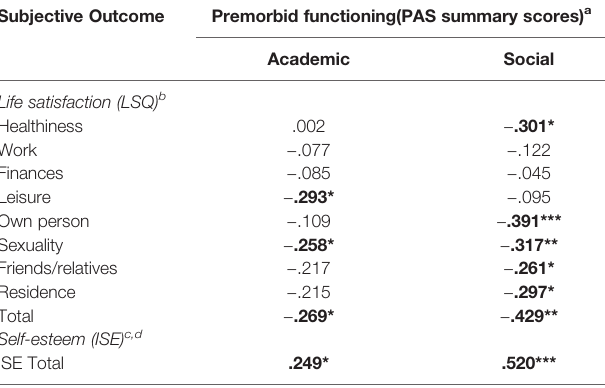
TABLE 4 | Association of premorbid functioning with life satisfaction and self- esteem (Spearman rank correlation). Subjective Outcome